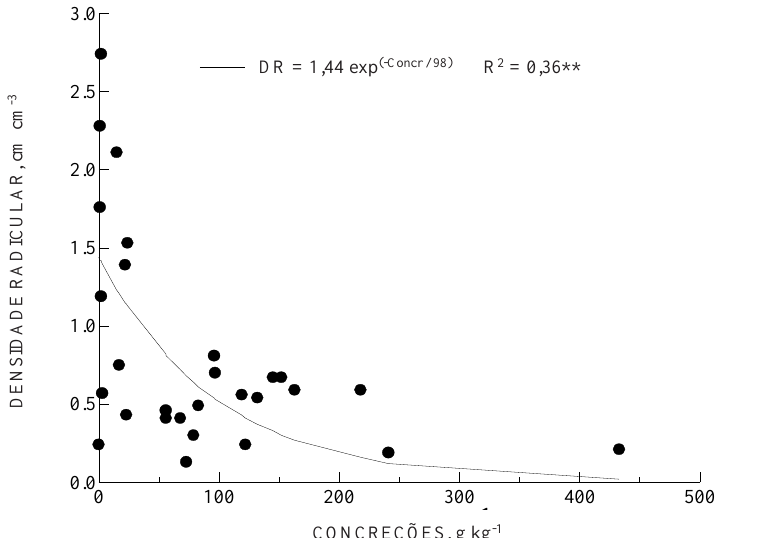
Figura 6. Relação entre a densidade radicular e os teores de concreções no solo, dos perfis profundos e rasos no Argissolo Vermelho distrófico arênico. n = 28 pares, ** significativo a 1% pelo teste t.